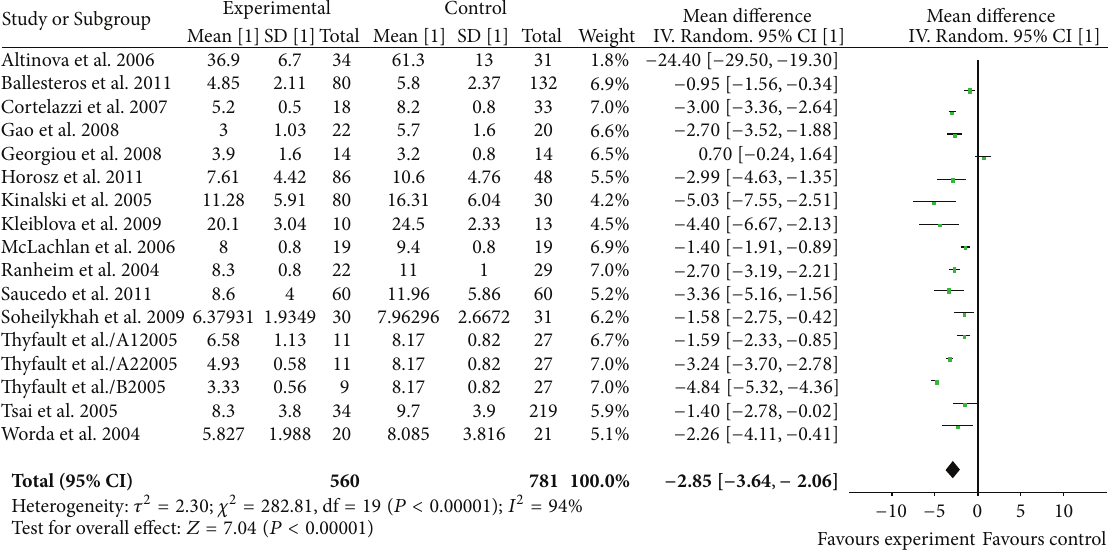
considered a leptin resistant state; circulating leptin